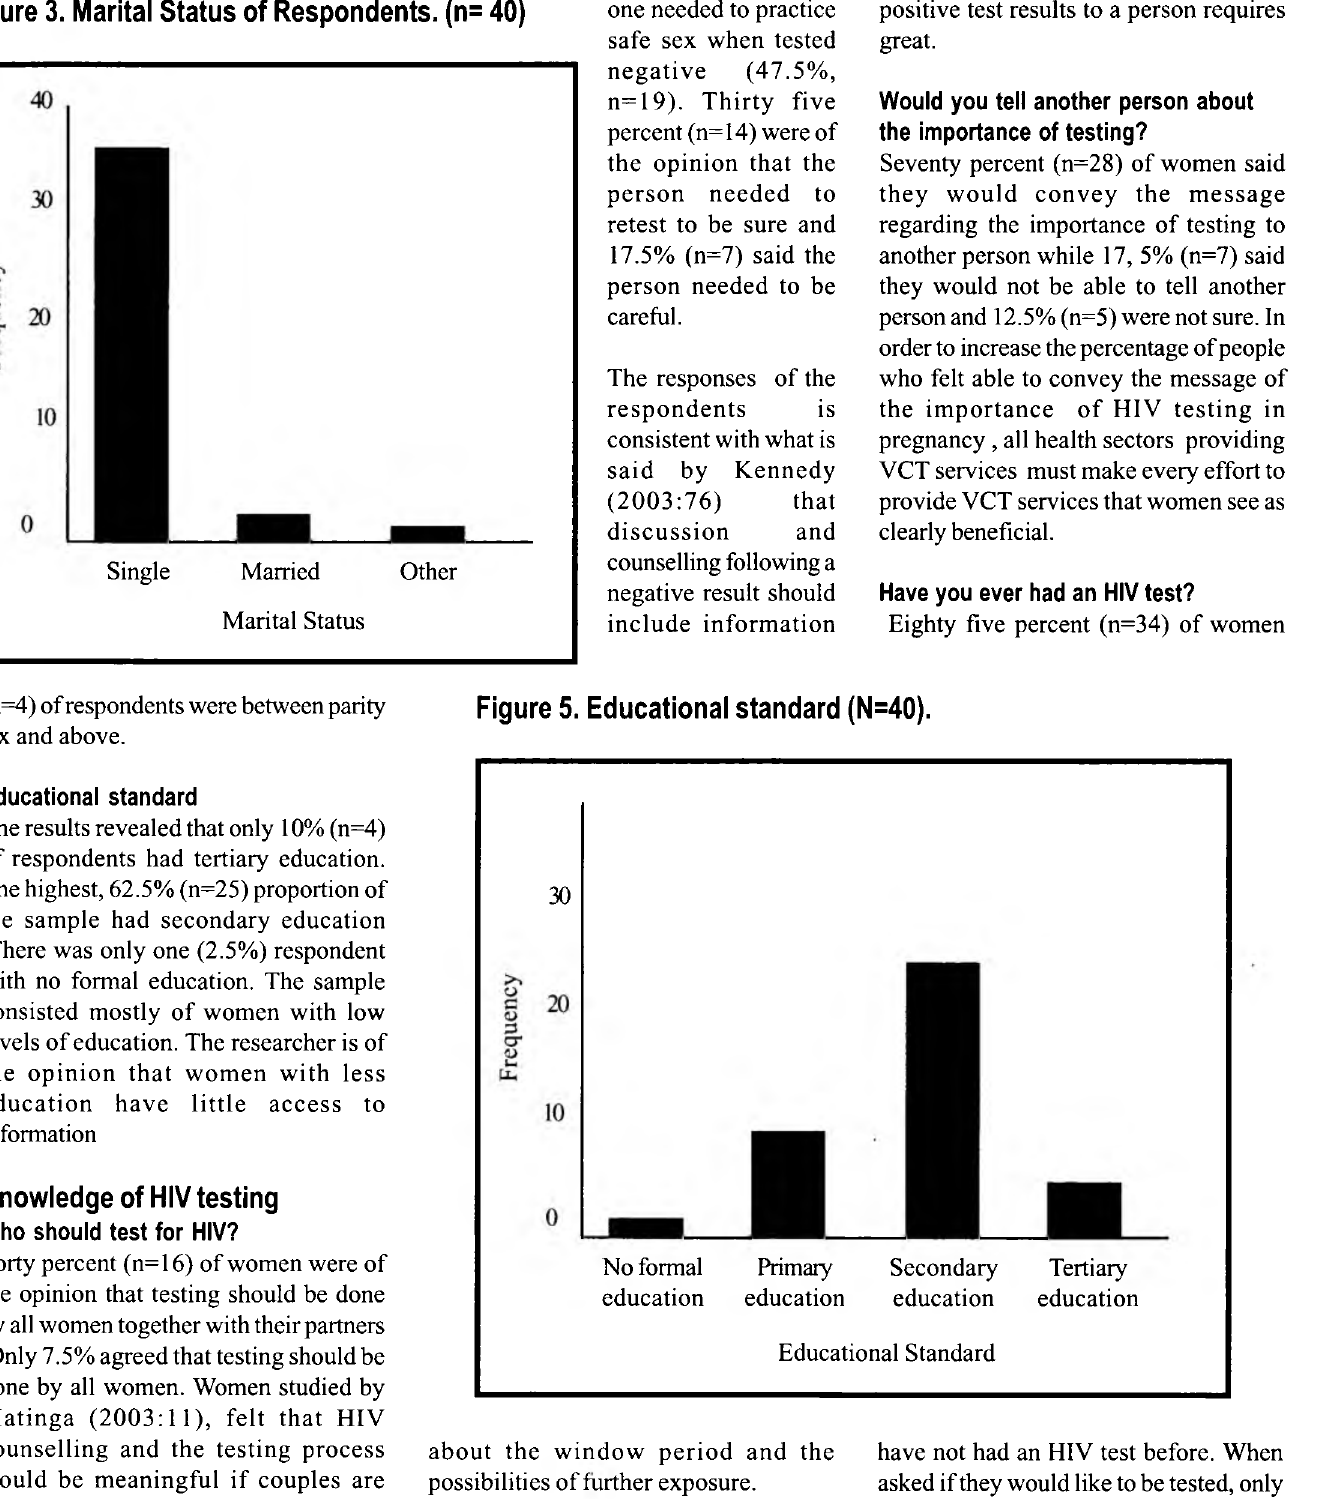
Figure 3. Marital Status of Respondents. (n= 40)